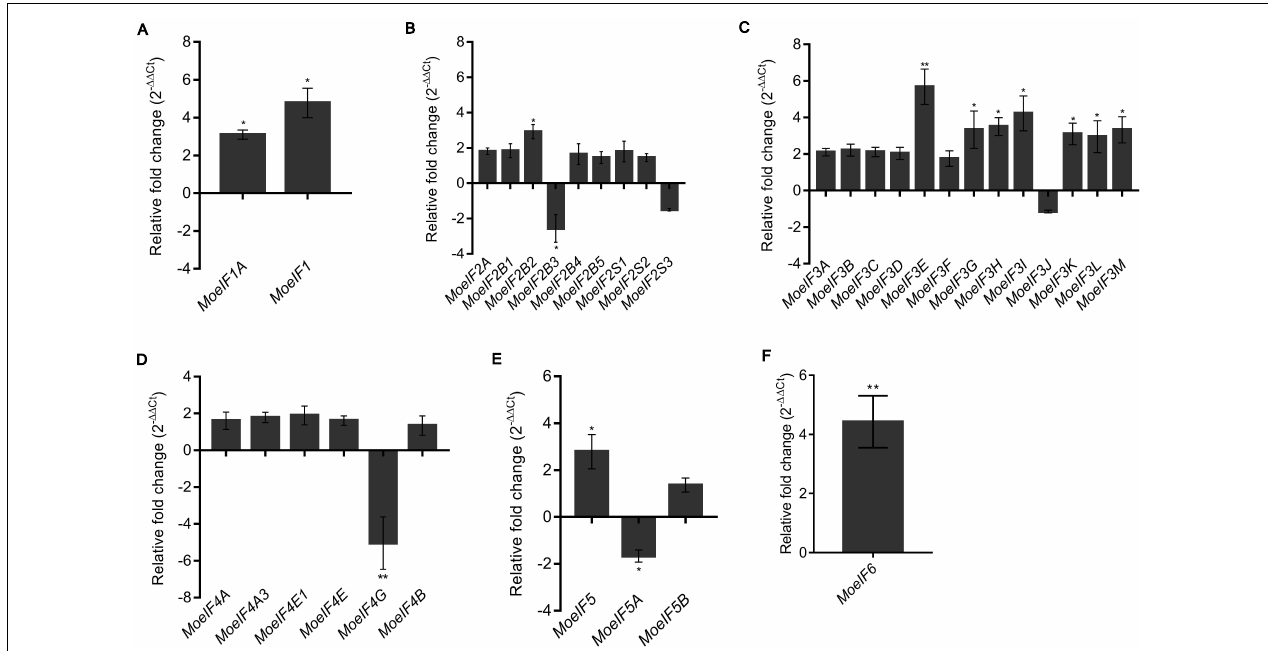
FIGURE 8 | Relative fold change in the expression profile of translation initiation factors of M. oryzae in MoeIF4E3 KO mutants. The graph shows expression profiling of (A) . eIF1 isomers, (B) . eIF2 complex, (C) . eIF3 complex, (D) . eIF4F complex and eIF4B, (E) . eIF5 complex, and (F) . eIF6 in vegetative hyphae of MoeIF4E3 KO mutants. Wild type Guy11 vegetative hyphae were used as control and assumed unity = 1. Error bars represent standard deviation (SD). SD was calculated from three independent biological replications along with three technical replicates. (** p < 0.01 and * p < 0.05, t